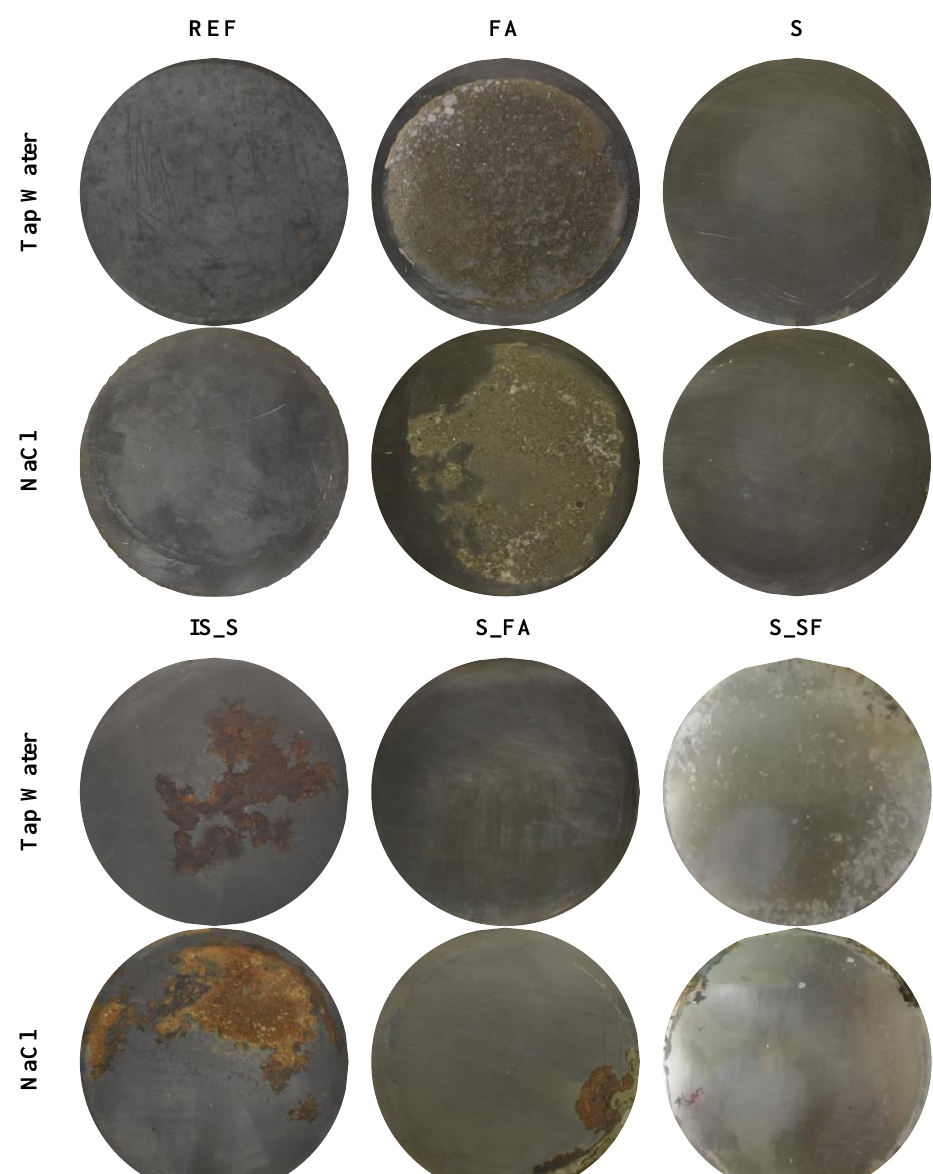
Figure 9. Visual appearance of steel surface at the end of testing, exposed to tap water and chloride solution.